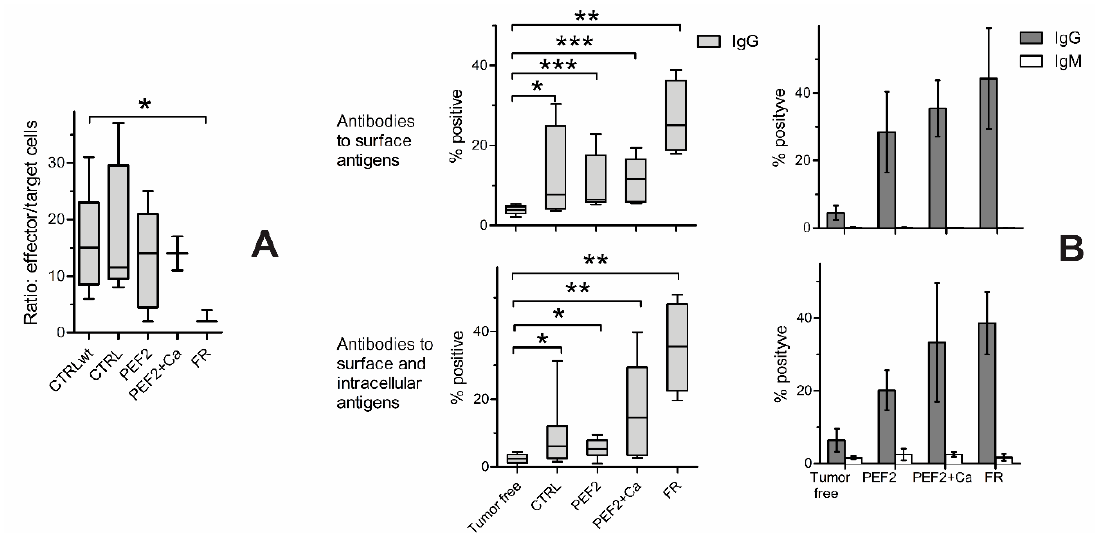
Figure 7. Anti-tumor immune response, where ( A ) Cytotoxic T Lymphocyte (CTL) killing assay. Y axis: Ratio effector/target cells when 50% of tumor cells are killed. Tumor free mice ( n = 5), CTRL - tumor bearing mice ( n = 6), PEF2 protocol treated mice ( n = 5), PEF2 + Ca treated mice ( n = 2), FR -full recovered mice ( n = 3); ( B ) Antibodies to surface and surface + intracellular SP2/0 myeloma cell antigens in murine sera. Immunoglobulin G (IgG) antibodies were determined in sera of tumor-free mice ( n = 8), CTRL ( n = 8), PEF2 ( n = 8), PEF2 + Ca ( n = 7), FR ( n = 4) (on the left). IgM and IgG antibodies (on the right) were determined in four selected samples of IgG anti-SP2/0 positive sera from every mouse group. Significant differences according to Mann Whitney test between the mice groups are marked by asterisks: * p < 0.05, ** p < 0.005, *** p < 0.0005.